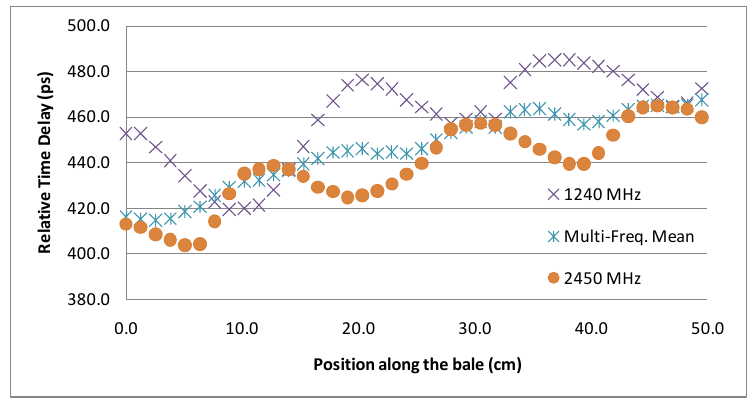
Figure 13. Comparison to single frequency estimate of propagation delay to an estimate derived from multiple frequencies showing a 4:1 reduction in signal